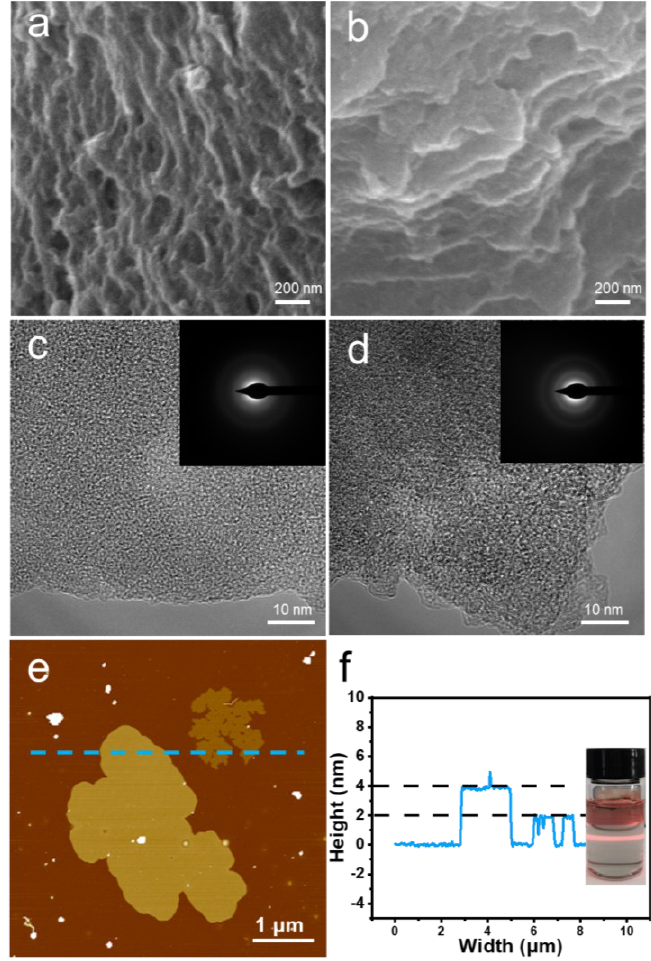
Figure 2. SEM images of ( a ) HCPB and ( b ) CHCPB; HRTEM images of ( c ) HCPB and ( d ) CHCPB; Inset: the SAED images; ( e ) AFM image of CHCPB nanosheet; ( f ) height profile along the line; Inset: optical image of CHCPB nanosheet in DMF solution.